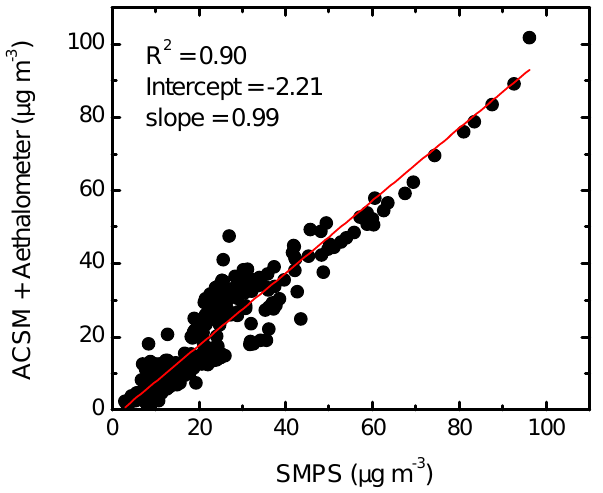
Figure 2. Comparison between the sum of the mass concentra- tions of species measured by the ACSM (assuming a CE of 1) and Aethalometer (at 880nm) vs. aerosol volume obtained from SMPS and time-dependent aerosol